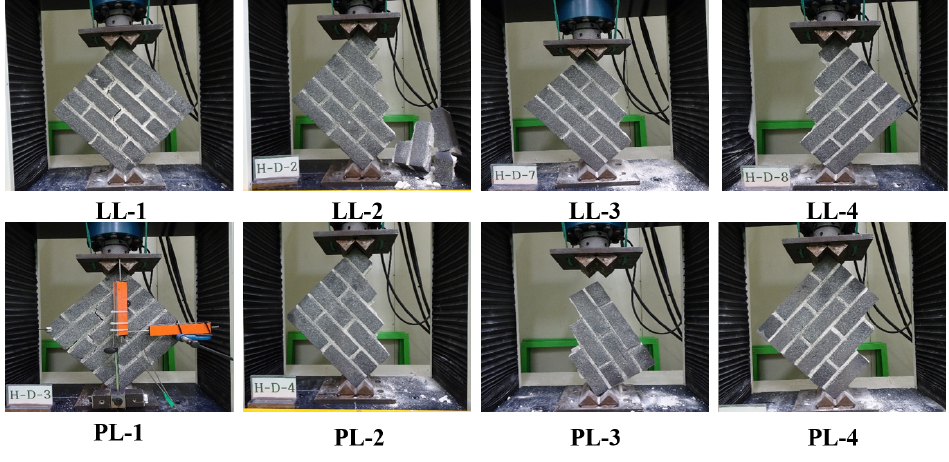
Figure 20. Failure mode diagonal compression